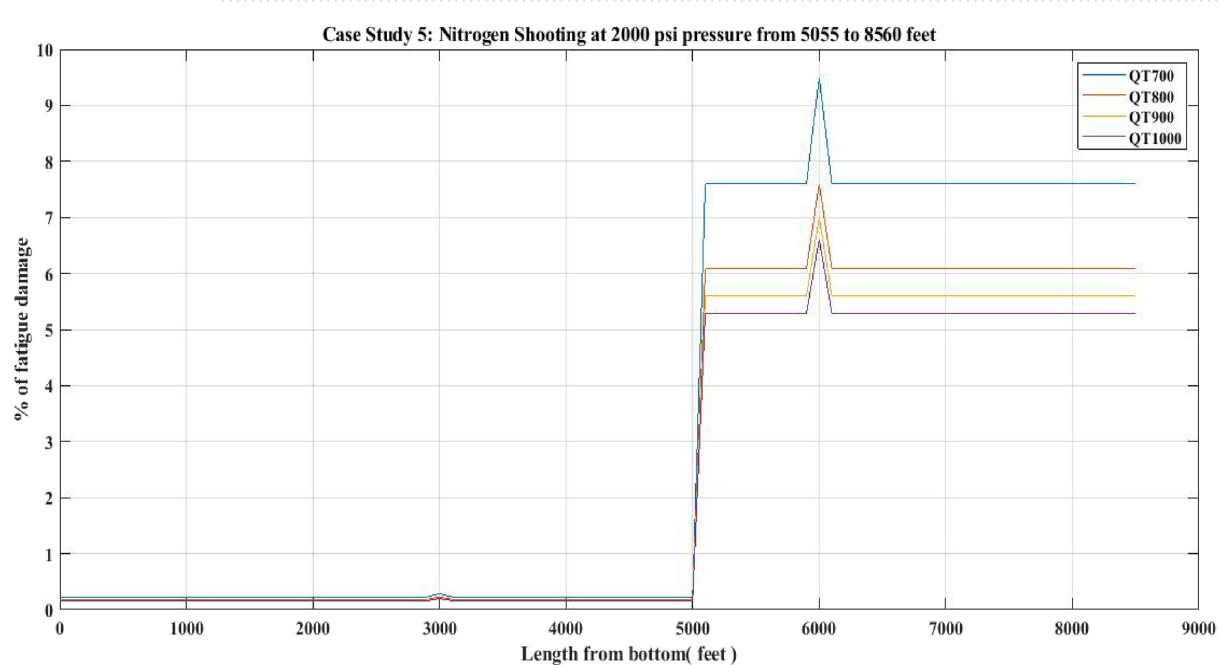
Figure 29. Percentage of fatigue damage with respect to Nitrogen Shooting at 2000 psi